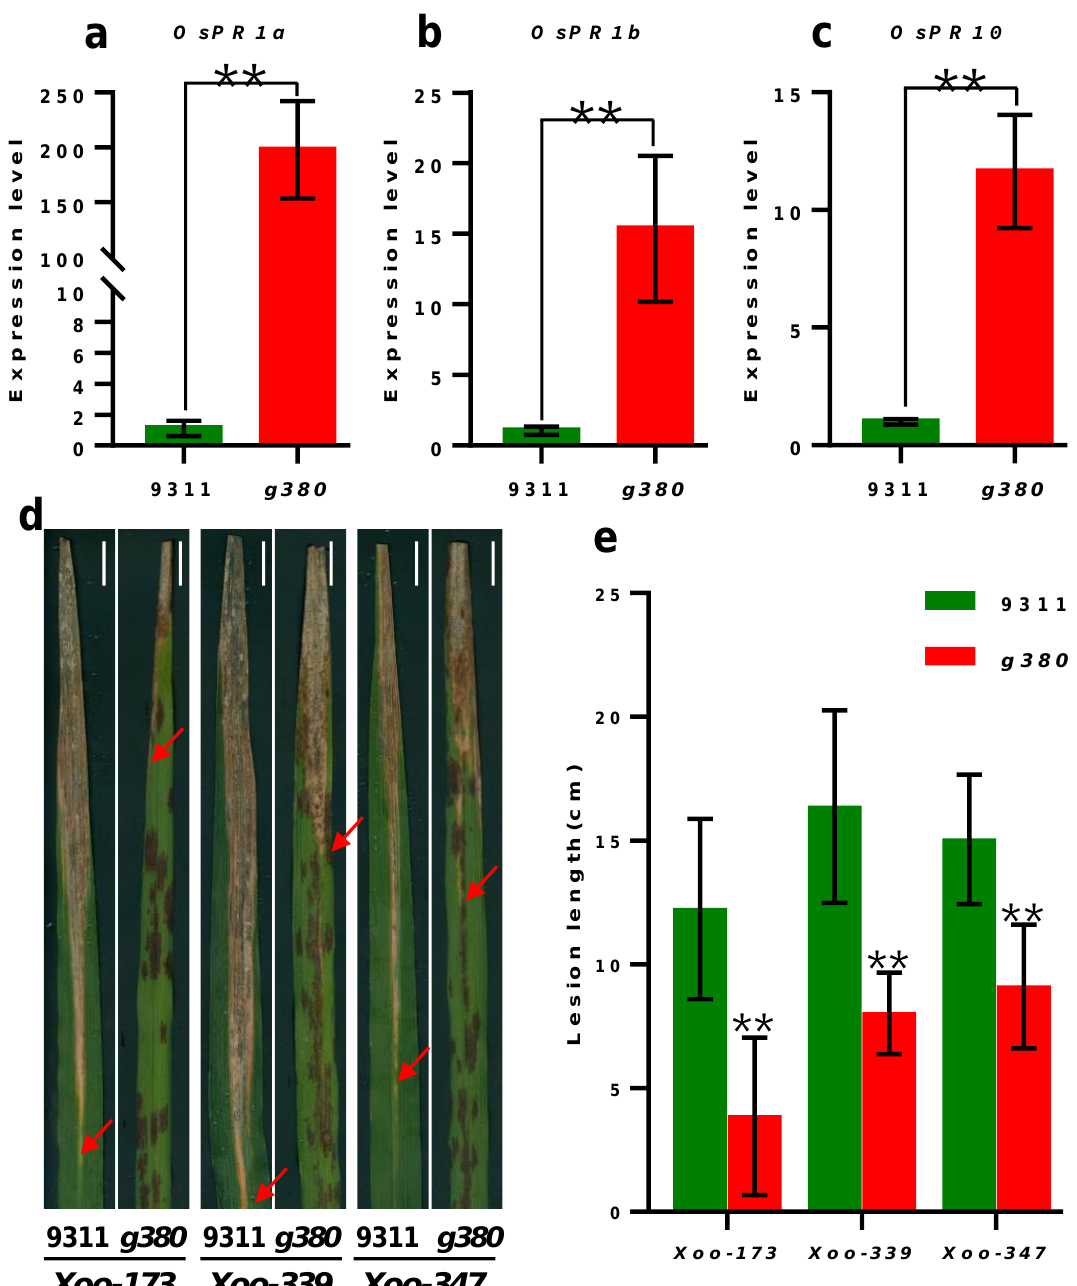
Figure 4. The expression levels of PR genes and the result of bacterial blight inoculation. ( a – c ) The expression levels of PR genes; values are mean ± SD ( n ≥ 6). ** indicates significant differences at p < 0.01 level by Welch’s t -test. ( d ) Phenotypes of representative leaves from the 9311 and g380 plants at 15 d after infection with Xoo-173 , Xoo-339 , and Xoo-347 ; bar = 1 cm. ( e ) Comparison of the lesion lengths on leaves from 9311 and g380 plants at 15 d after infection with Xoo-173 , Xoo-339 , and Xoo-347 ( n ≥ 6); ** means p < 0.01 level by Welch’s t -test.